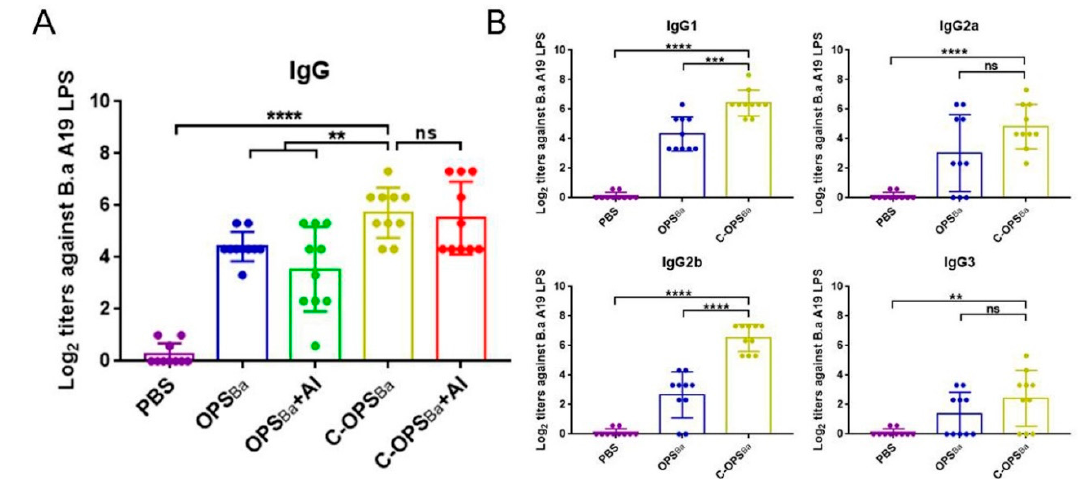
Figure 2. IgG responses against B. abortus A19 lipopolysaccharide (LPS). ( A ) IgG titers against A19 LPS were measured in sera from PBS-, OPS Ba -, OPS Ba + Al-, C-OPS Ba -, and C-OPS Ba + Al-vaccinated mice. ( B ) IgG subclass titers (IgG1, IgG2a, IgG2b, and IgG3) against A19 LPS were measured in sera from PBS-, OPS Ba -, and C-OPS Ba -vaccinated mice. Each value represents the mean ± standard deviation of log 2 -transformed titers in the sera of individual mice (shown as data points on the graphs) from each group ( n = 10). The unpaired t -test was used to evaluate differences between IgG titers (**, p <0.01; ****, p <0.0001; ns, no statistically significant difference).